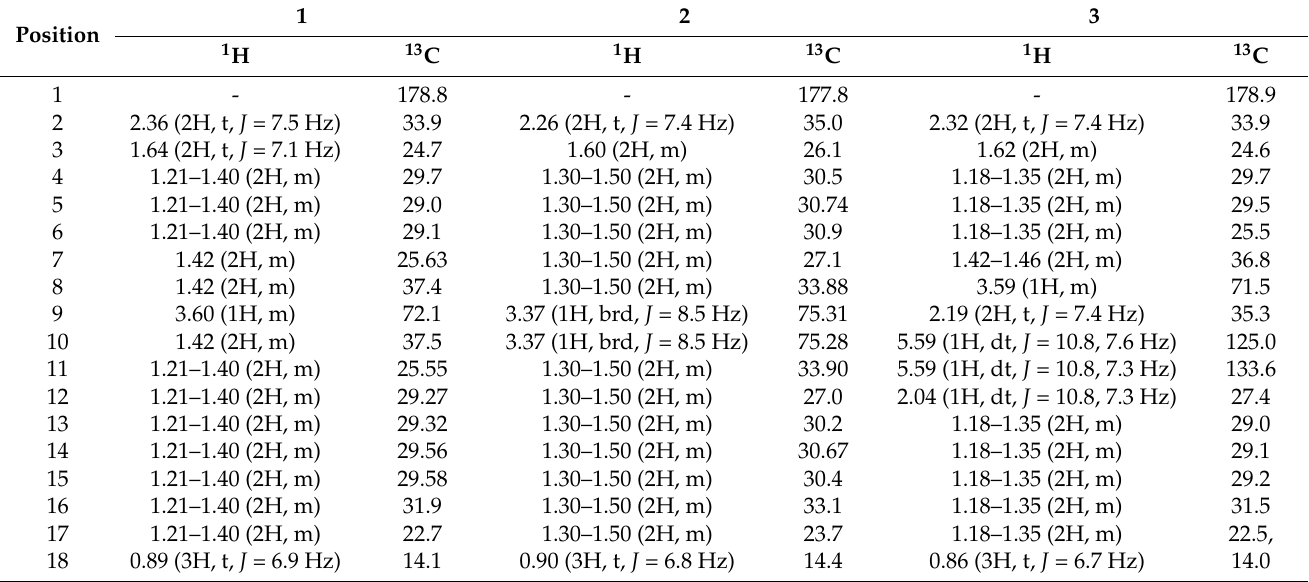
Table 1. The NMR data of compounds 1 – 3 .